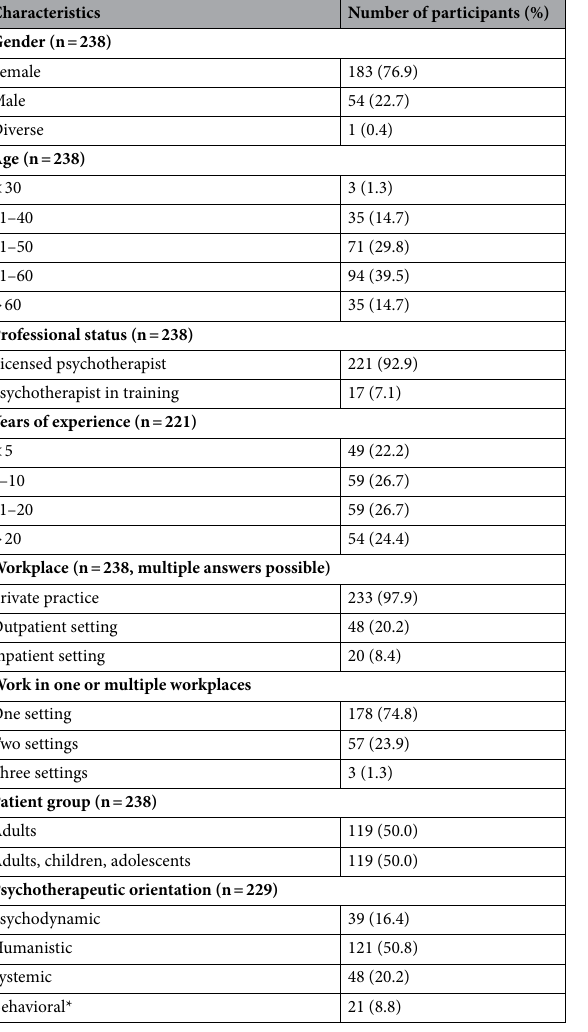
Table 1. Characteristics of the participants. The sample size for psychotherapeutic orientation is smaller, since we excluded those with multiple answers (n = 9) to be able to calculate independent comparisons between the orientations. The sample size for “years of experience” is smaller, since we excluded psychotherapists in training (n = 17). Abbreviations: n = number of respondents. * Behavioral therapy in Austria comprises